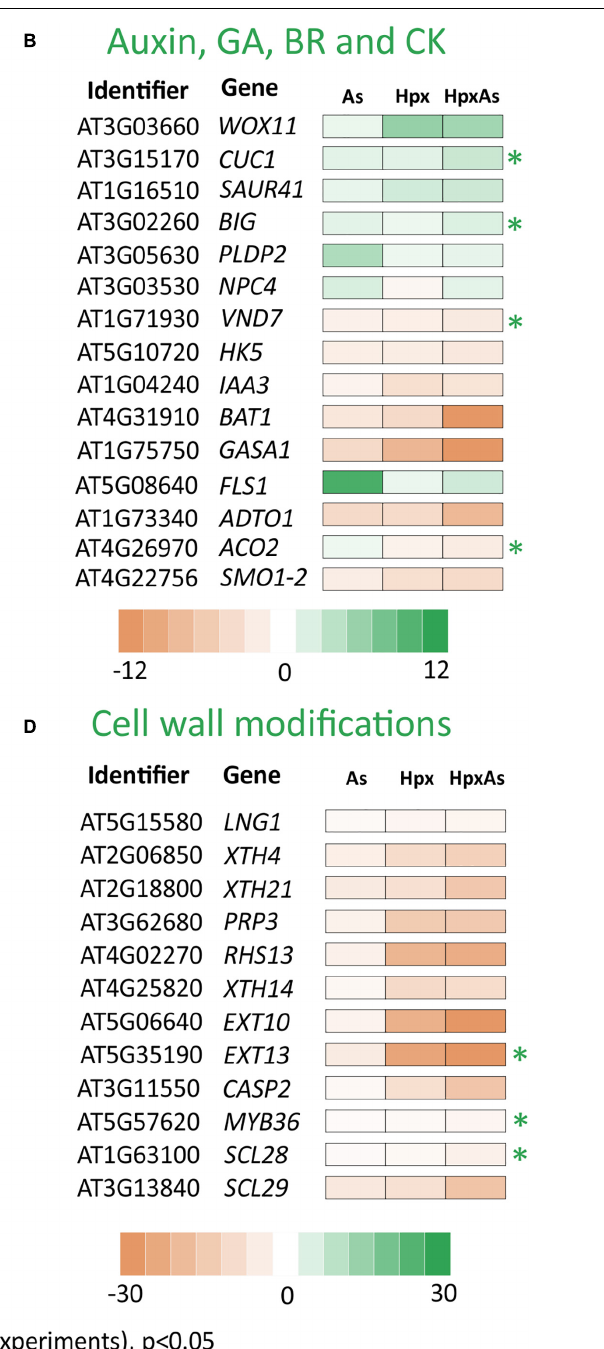
Frontiers in Plant Science |